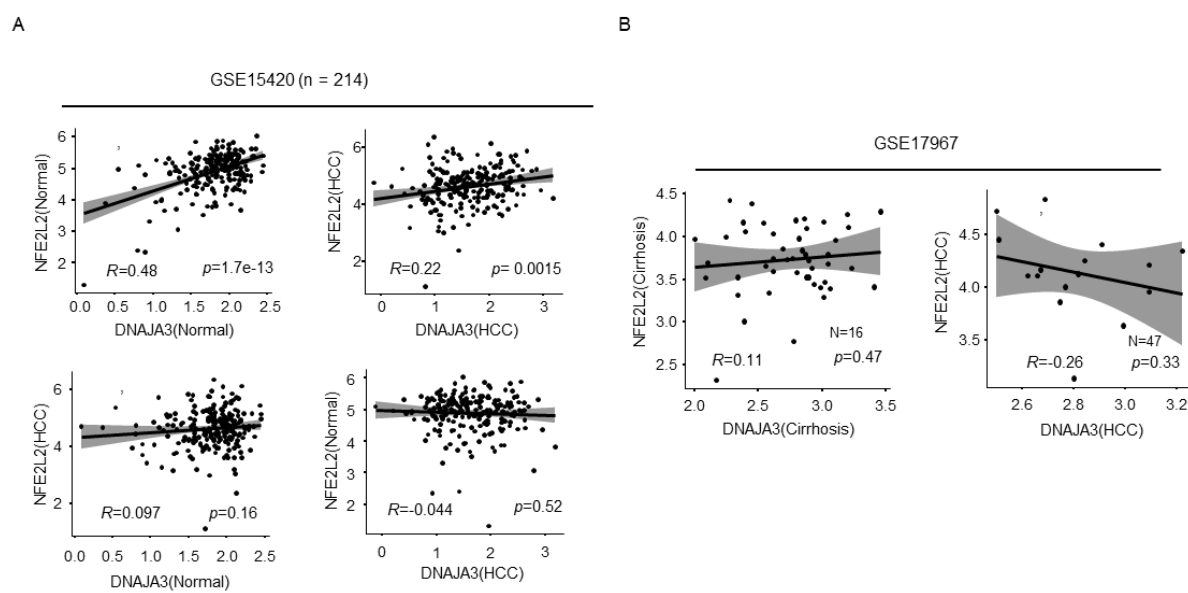
Figure 2. Expression correlation between the NDAJA3 (Tid1) and NFE2L2 (Nrf2) transcripts in normal liver, cirrhosis, and HCC. Expression correlation analysis between DNAJA3 and NFE2L2 genes in liver cancer cohort (GSE15420 ( A ) and GSE17967 ( B )). HCC indicates liver cancer tissue, Normal indicates non-cancer tissue, and Cirrhosis indicates tissue with cirrhosis but no liver cancer. R indicates correlation coefficient, p indicates significance, and n indicates sample capacity.